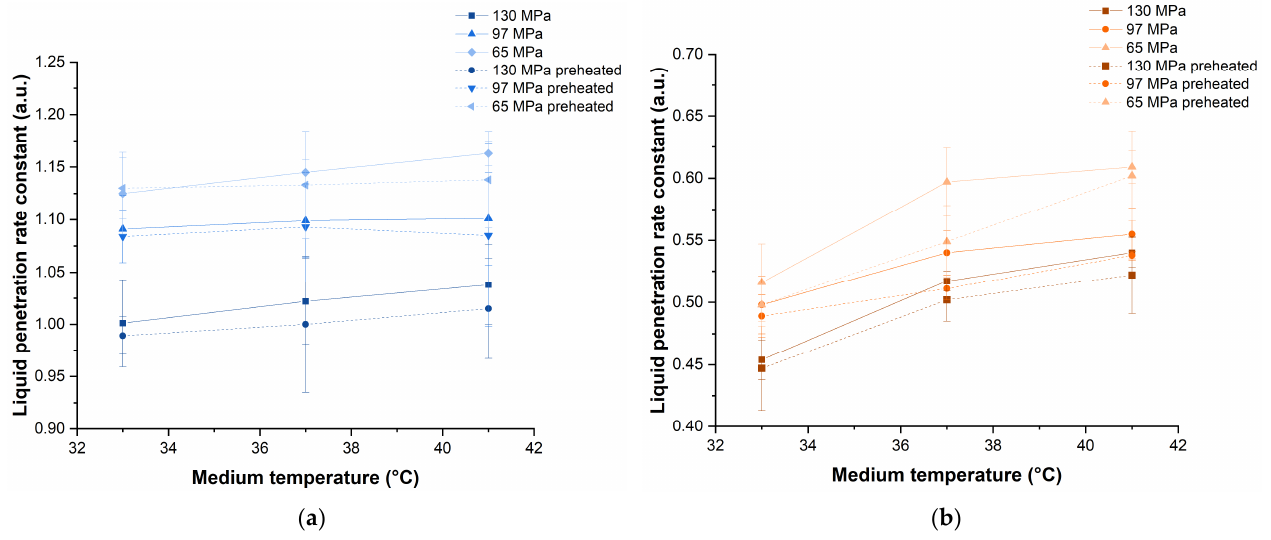
Figure 6. Plots of liquid penetration rate constant against medium temperature for tablets contain- ing ( a ) SSG and ( b ) XPVP, with or without preheating, produced at different compaction pressures.